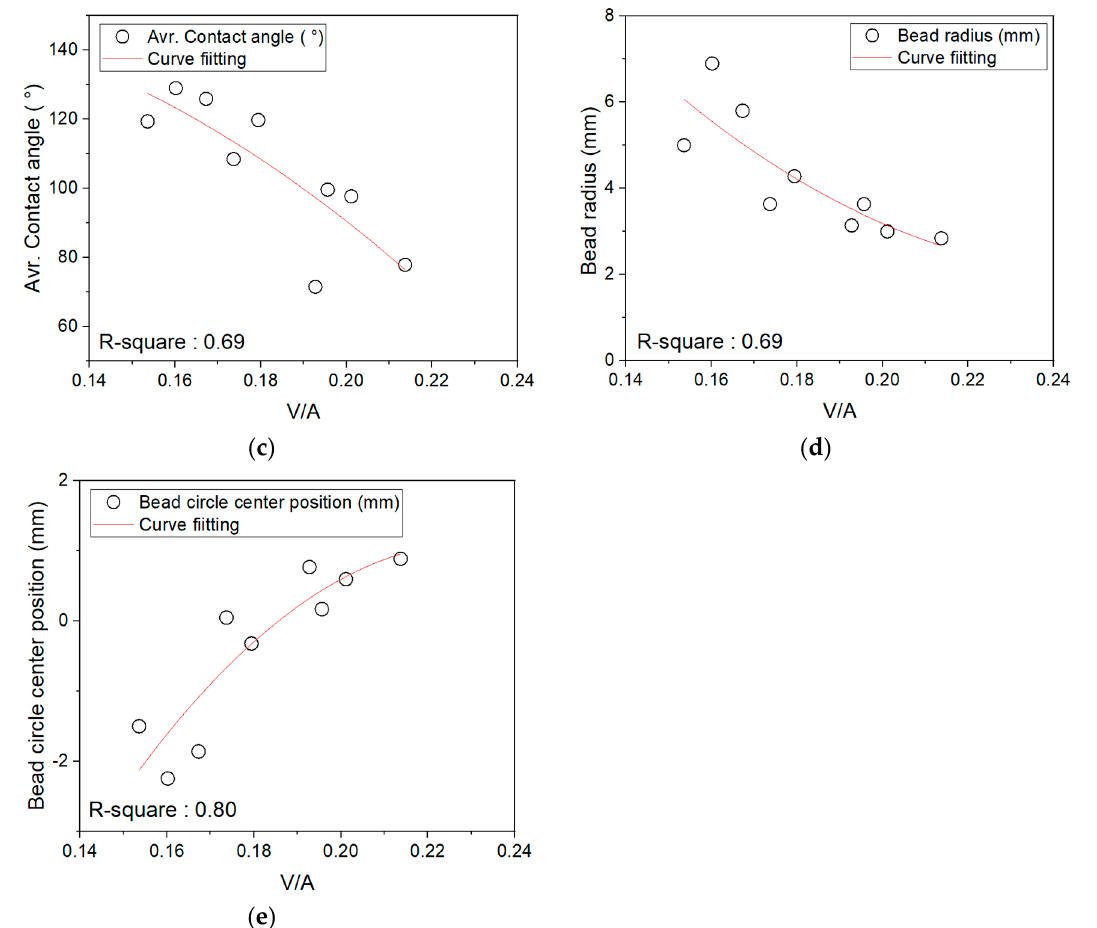
Figure 7. Geometry fluctuation of beads according to the current and voltage ratio. ( a ) Current and voltage ratio versus width. ( b ) Current and voltage ratio versus height. ( c ) Current and voltage ratio versus contact angle. ( d ) Current and voltage ratio versus bead radius. ( e ) Current and voltage ratio versus circle center position.